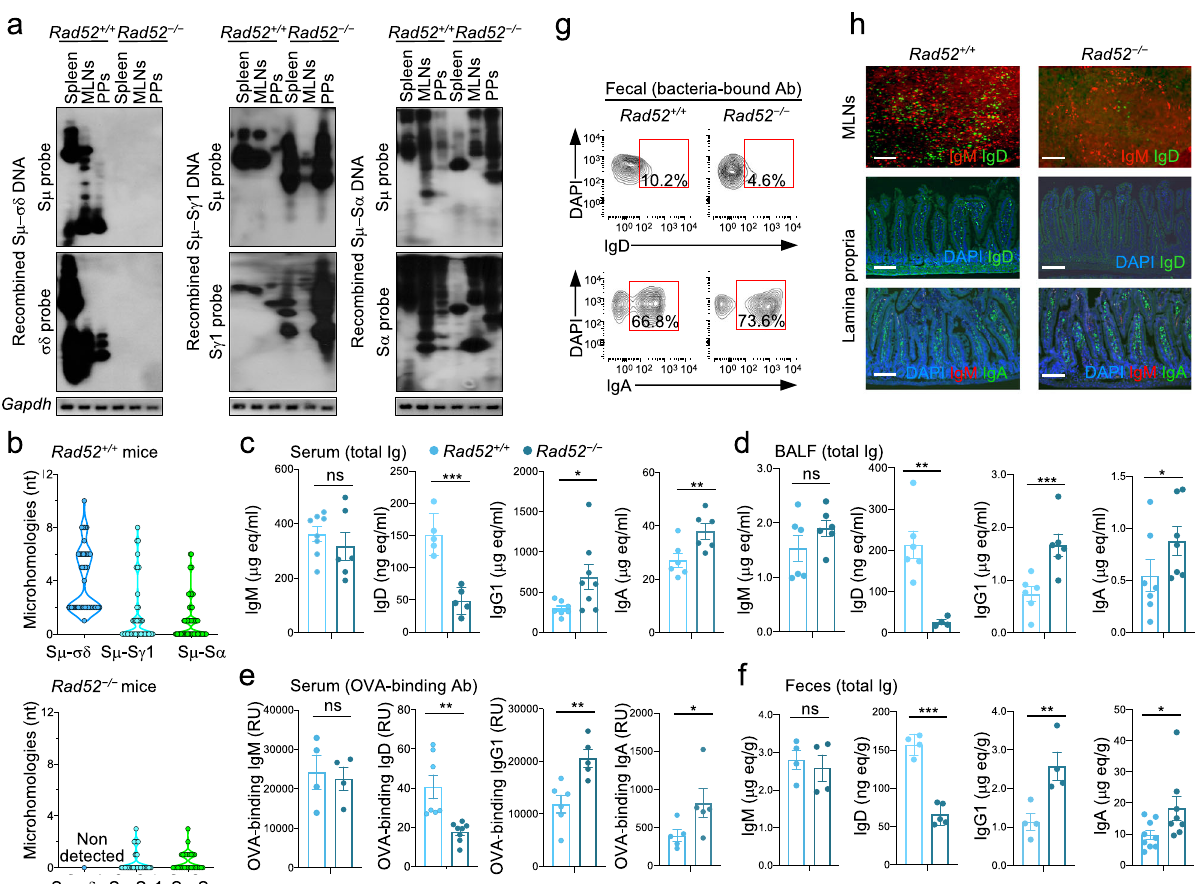
Fig. 5 Rad52 deletion ablates in vivo S μ – σδ DNA recombination and reduces IgD production. Rad52 + / + and Rad52 − / − mice were immunized